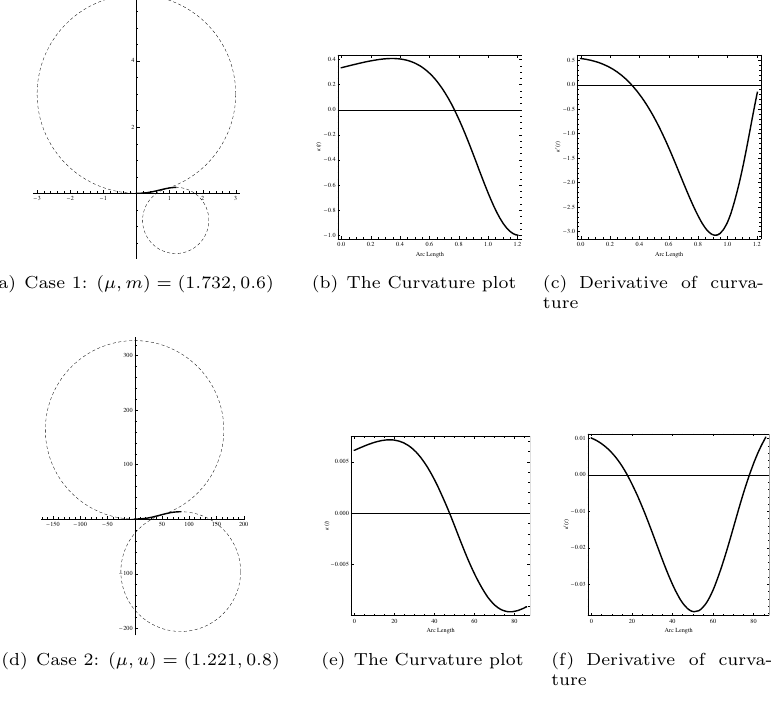
Figure 8. S-shaped transition curves (left) with single (upper) and double (down) curvature